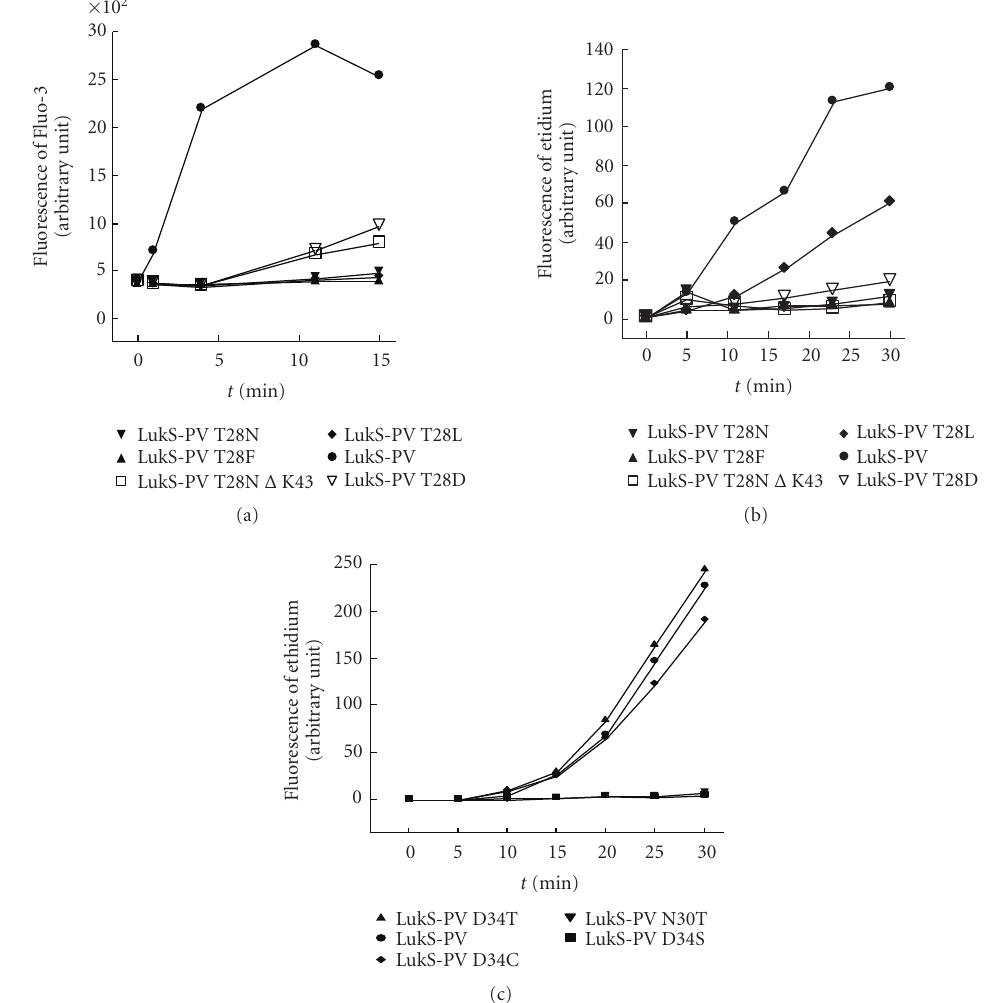
Figure 7: Determination by flow cytometry of (a) the opening of calcium channel in the presence of 1mM of calcium by the measurement of the fluorescence intensity of Fluo-3 ( λ ex = 488 nm, λ em = 530 nm) and (b), (c) the formation of the pores into membranes in absence of calcium by the measuring of the fluorescence intensity of ethidium ( λ ex = 488 nm, λ em = 650 nm) for LukS-PV and the mutated proteins (2nM) associated to LukF-PV (0.75 nM) on the membrane of human PMNs (2 × 105